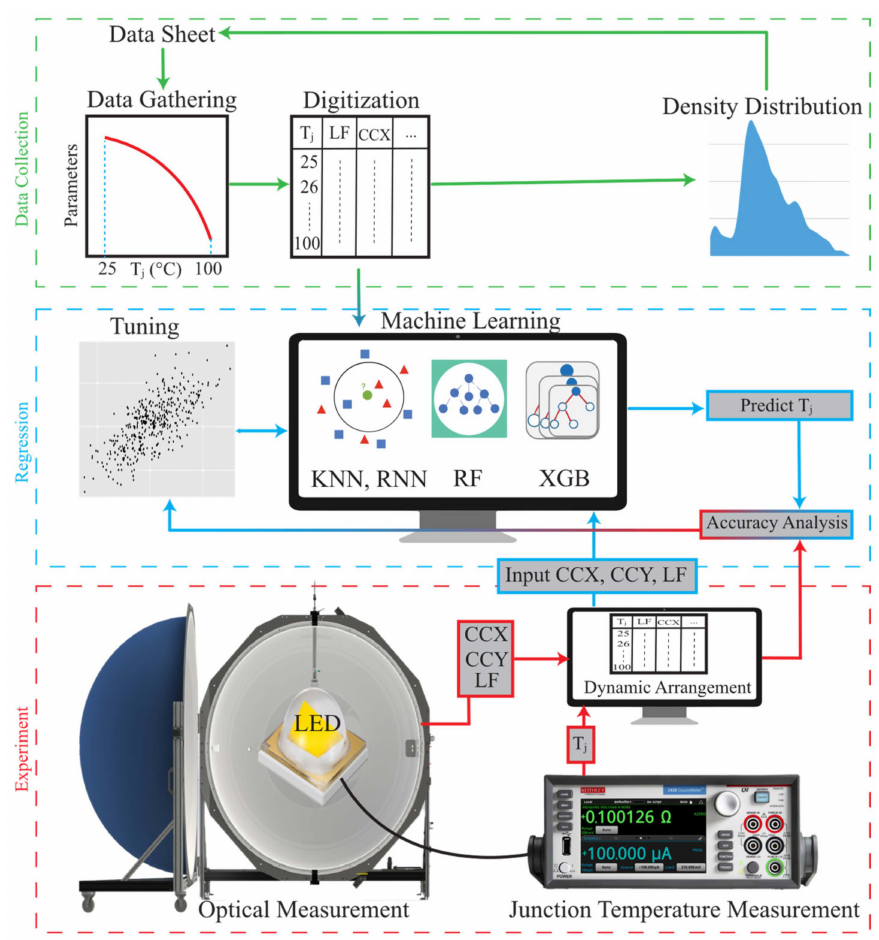
Figure 2. Overview of data collection, regression, and experiments and their